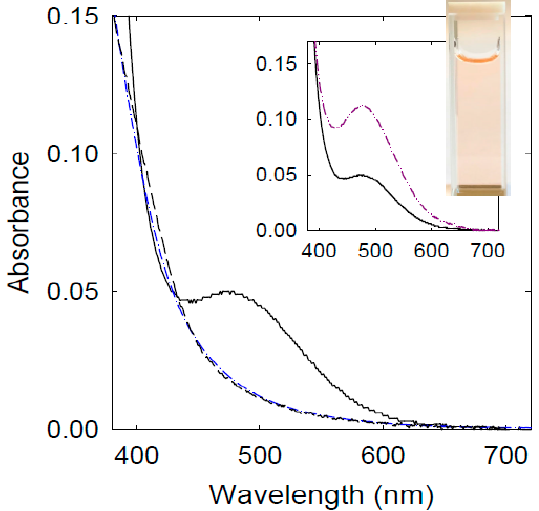
Figure 2. The absorption spectrum of the as-supplied MilliporeSigma sample solution (measured five days after the sample was received, solid line) compared with those of the aqueous dispersed small carbon nanoparticles (dash line, from reference 17) and EDA-CDots (dash-dot-dash line). Insert: The same absorption spectrum of the as-supplied MilliporeSigma sample solution (solid line) compared with the spectrum of the same sample solution measured six weeks after (dash-dot-dot-dash line). Moreover, in the inset is a photo of the as-supplied sample solution.